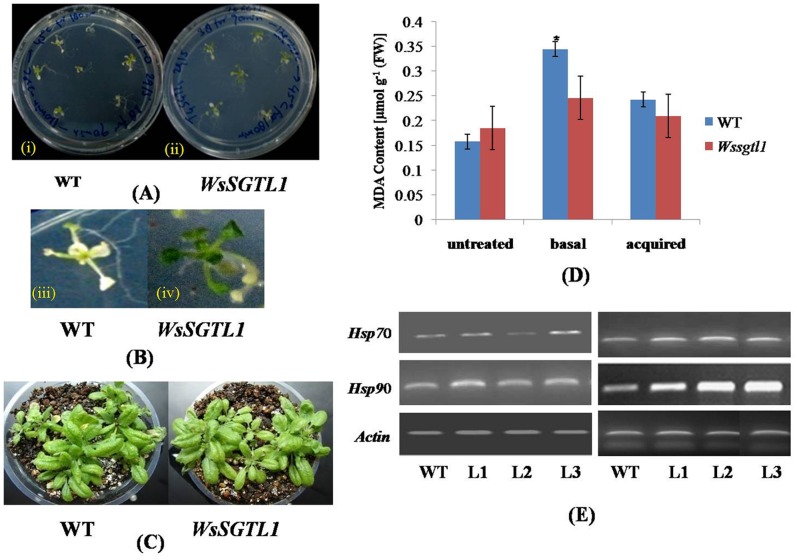
Phenotypes and heat tolerance of the transgenic plants.Thermotolerant phenotypes of WT and overexpression lines of A.thaliana, showing heat sensitivity at 7-d-old seedlings stage. Seedlings were grown on agar plates in light for 7 d and heated at 38°C for 90 min, cooled at room temperature for 120 min, and again heated at 42°C for 180 min (acquired thermotolerance). Percentage of survival of plants in relation to WT control plants on the same plate was determined 5 d after heat stress (A–B). Three-weeks-old soil grown plants exposed directly to 42°C for 60 min (basal thermotolerance). Photograph was taken after 7 day survival of the plants (C). Heat-induced oxidative damage in WT as compared to overexpression lines with decreased thermotolerance. Plants were heat treated as described in Figure (A), and after 2 days of recovery, seedlings were harvested and stored in liquid nitrogen until the assay was performed. The MDA level determined from the overexpression lines of A.thaliana in relation to WT control on each plate was determined. Values are expressed as mean (n = 3); errors bars show the SD for each experiment. (*) P≤0.05 compared to WT (t-test) (D). Two-weeks-old seedlings of WT and all transgenic lines were used for RNA extraction. For heat stress, seedlings were kept at 42°C for 4 h before RNA isolation. The transcript level of two stress genes was determined by RT-PCR analyses. The stress genes used for the tests were Hsp70, Hsp90 (E).